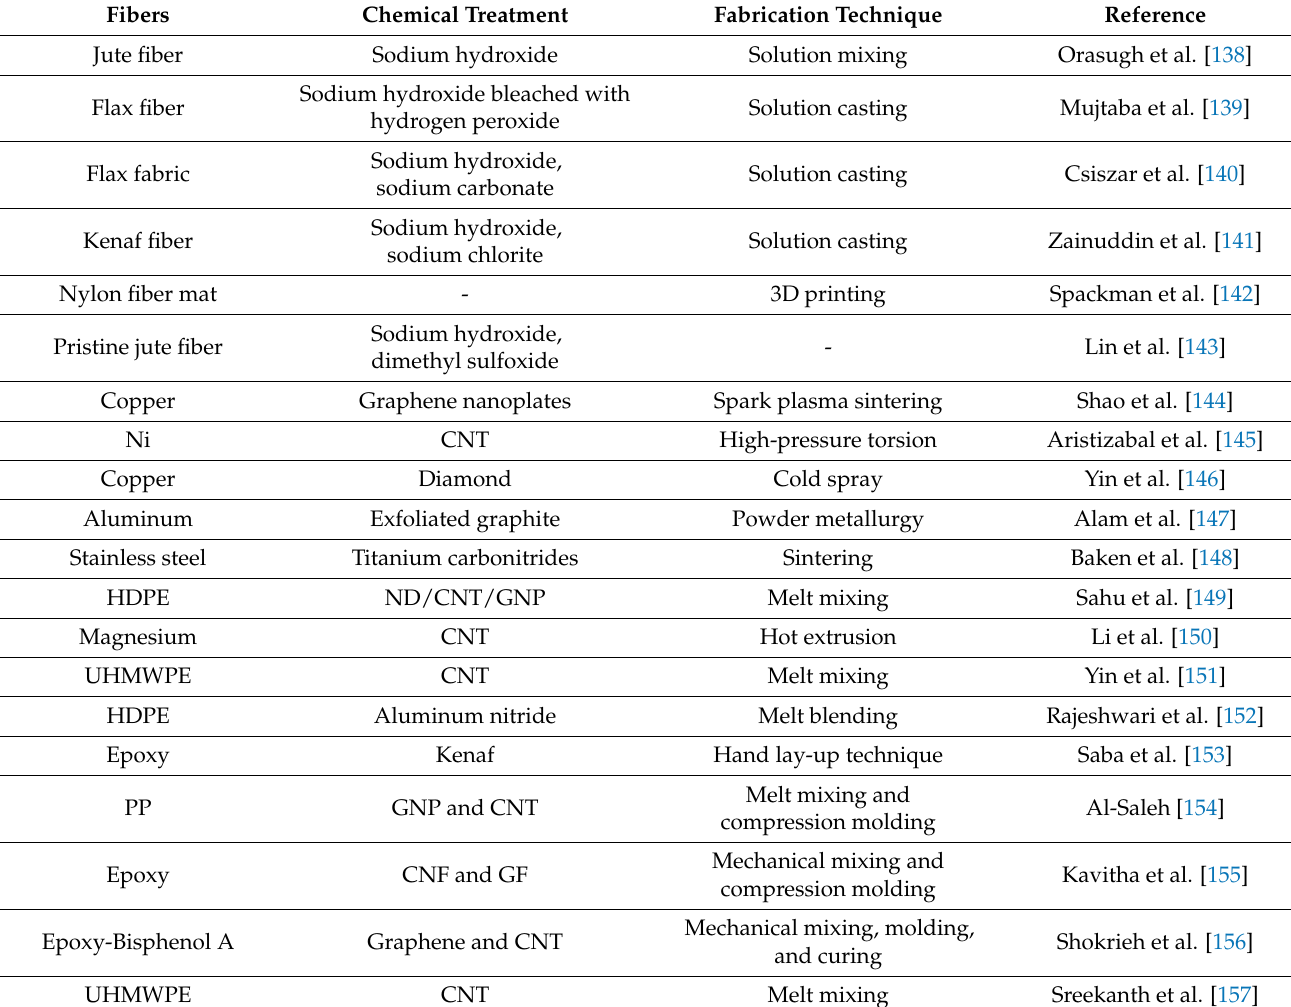
Table 1. Literature on FRP, MMC, and